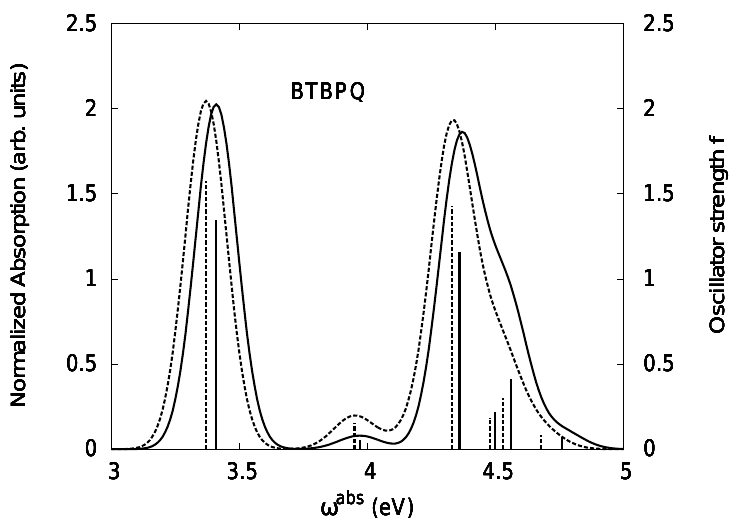
Figure 3. The same as Figure 2, but for